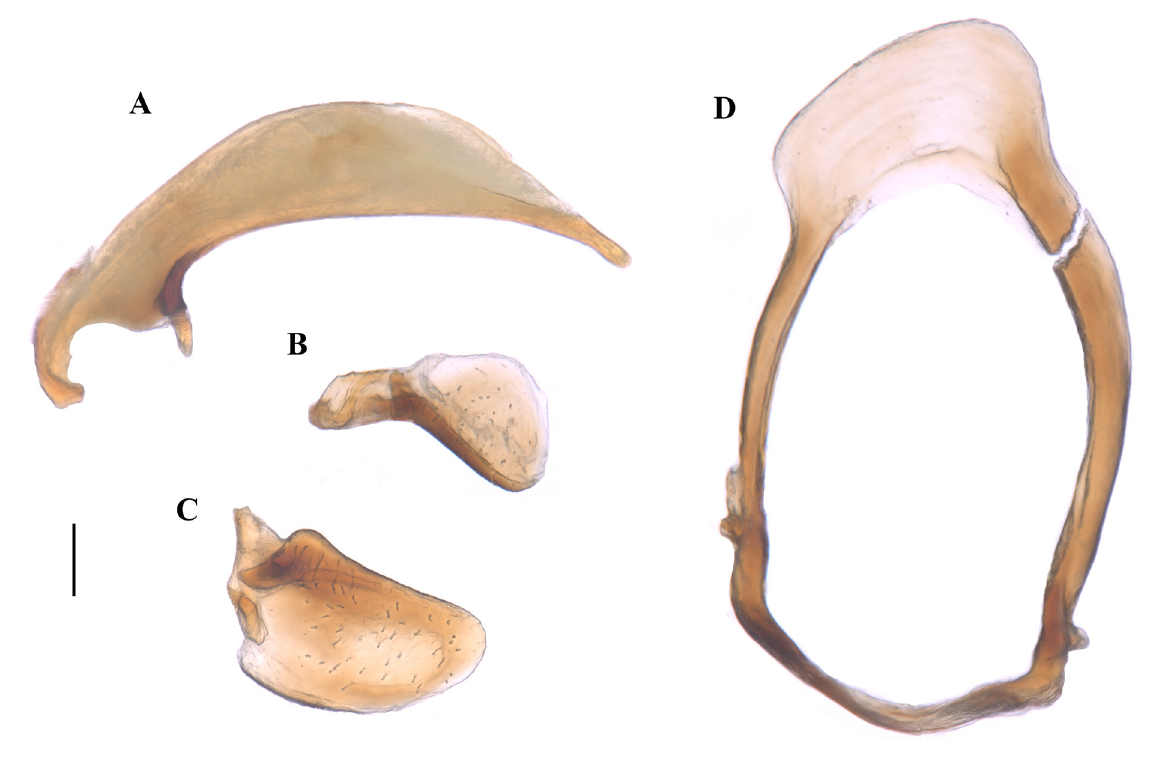
Fig. 3. Male genitalia, Perigona ( Neoperigona ) spelunca sp. nov. (ISLA 361). A . Median lobe of the aedeagus in lateral view. B . Right paramere. C . Left paramere. D . Male gonosomite. Scale bar = 0.1